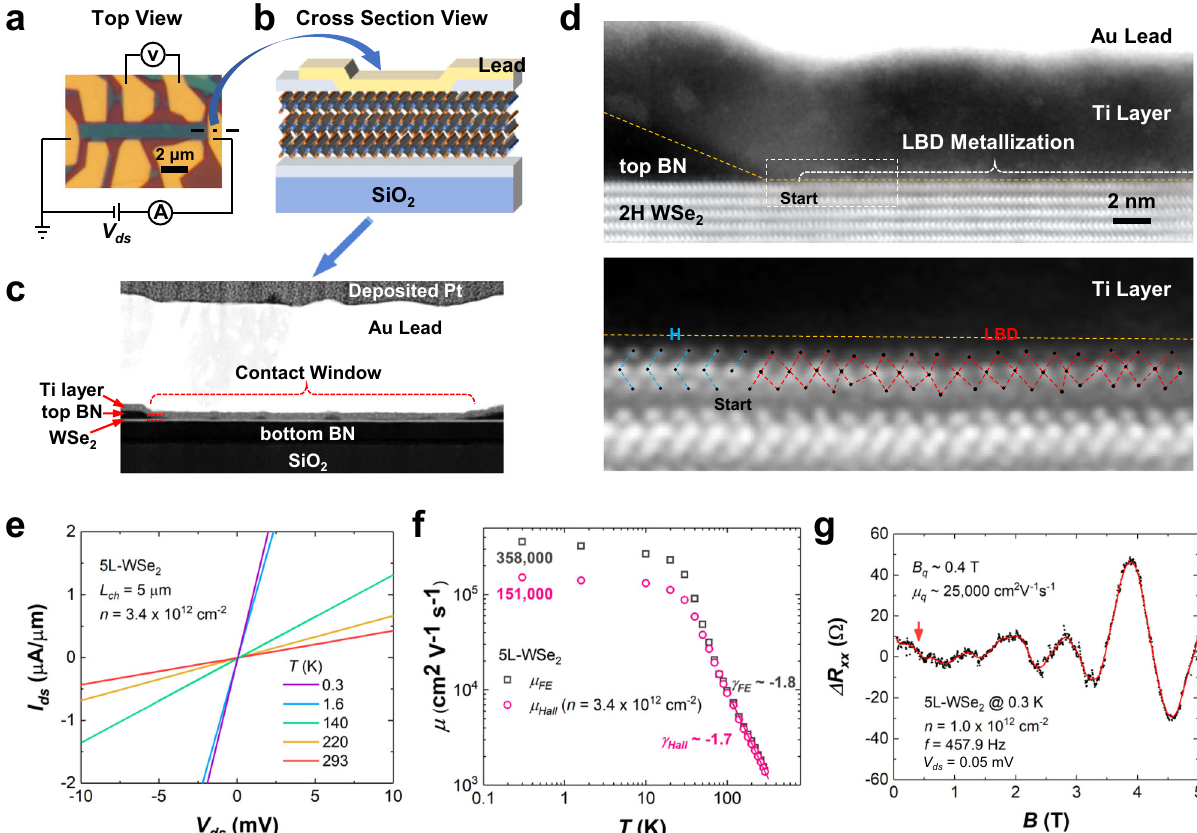
Fig. 5 Generality of the LBD strategy. a Optical image of a typical 5L-WSe 2 FET utilizing LBD contacts. The dash-dot line indicates the cutting position in the source, from which a cross-section membrane was lifted out as illustrated in b . c The low-magni fi cation ADF image of the contact region. The area in the red-dash rectangle is zoomed in as d . d Atomic-resolution ADF image of the WSe 2 -LBD-metal junction observed along the WSe 2 zig-zag direction. The orange dashed lines show the bottom of Ti layer. The LBD-starting region (white dashed rectangle) is analyzed below with the contrast re-surveyed, and the atomic model overlaid to clarify the distorted bonding. The overlaid blue and red dashed lines highlight the lattices of hexagonal WSe 2 (H) and octahedral WSe 2 (LBD), respectively. e Tow-probe I ds – V ds curves at varied temperatures. f Log-scale plot of fi eld-effect and Hall mobilities as the function of temperatures. γ FE and γ Hall represent the exponential temperature decay constants of the fi eld-effect and Hall mobilities, respectively. g Shubnikov de Haas (SdH) oscillations of the longitudinal channel resistance at low magnetic fi eld strength down to ~0.4 T, indicating the high quantum mobility. The solid red line is averaged from the nearest 25 data points and the red arrow indicates the prominent onset position of SdH oscillations at ~0.4